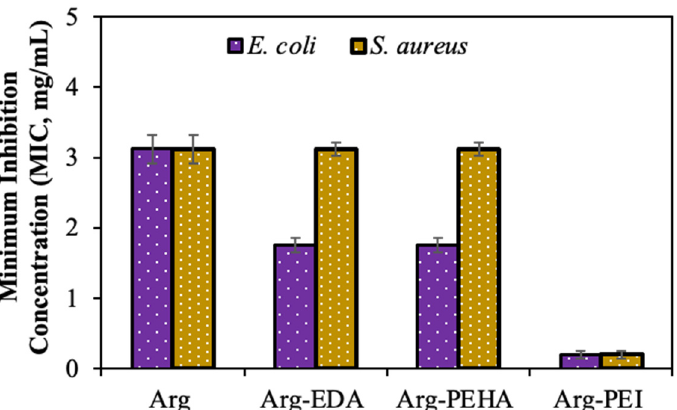
Figure 6. Minimum inhibition concentration (MIC) of Arg, Arg-EDA, Arg-PEHA, Arg-PEI CDs against E. coli ATCC 8739 (gram -) and S. aureus ATCC 6538 (gram +) for 24 h incubation time.